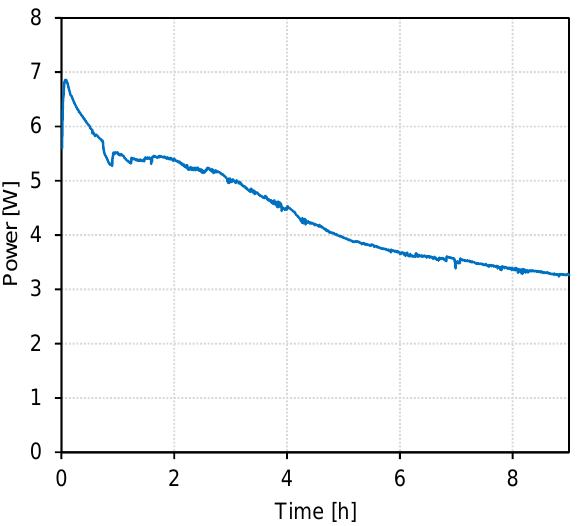
Figure 2. Power over treatment time for the batch EDBM treatment of BL permeate, U cell = 10 V (constant).